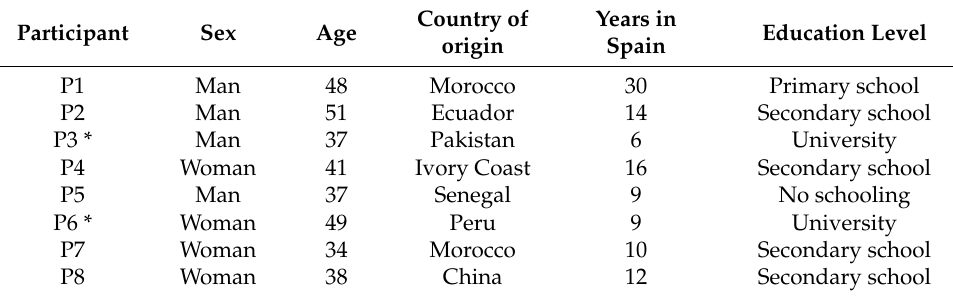
Table 1. Characteristics of focus group